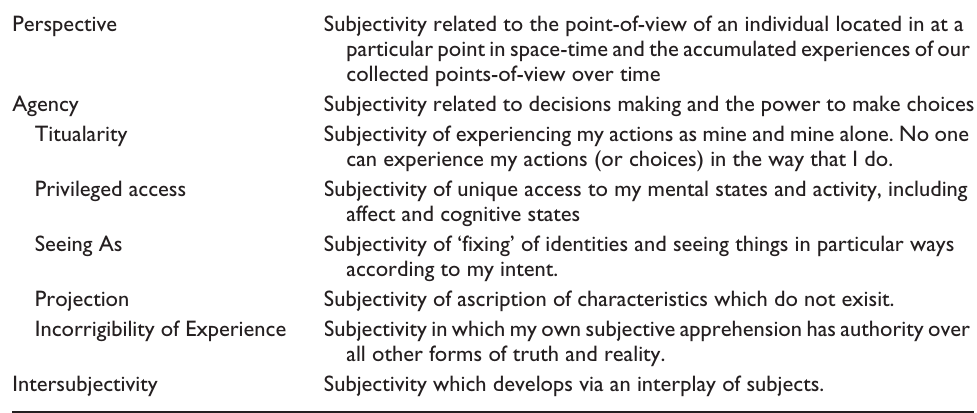
Table 1. Variations of subjectivity.